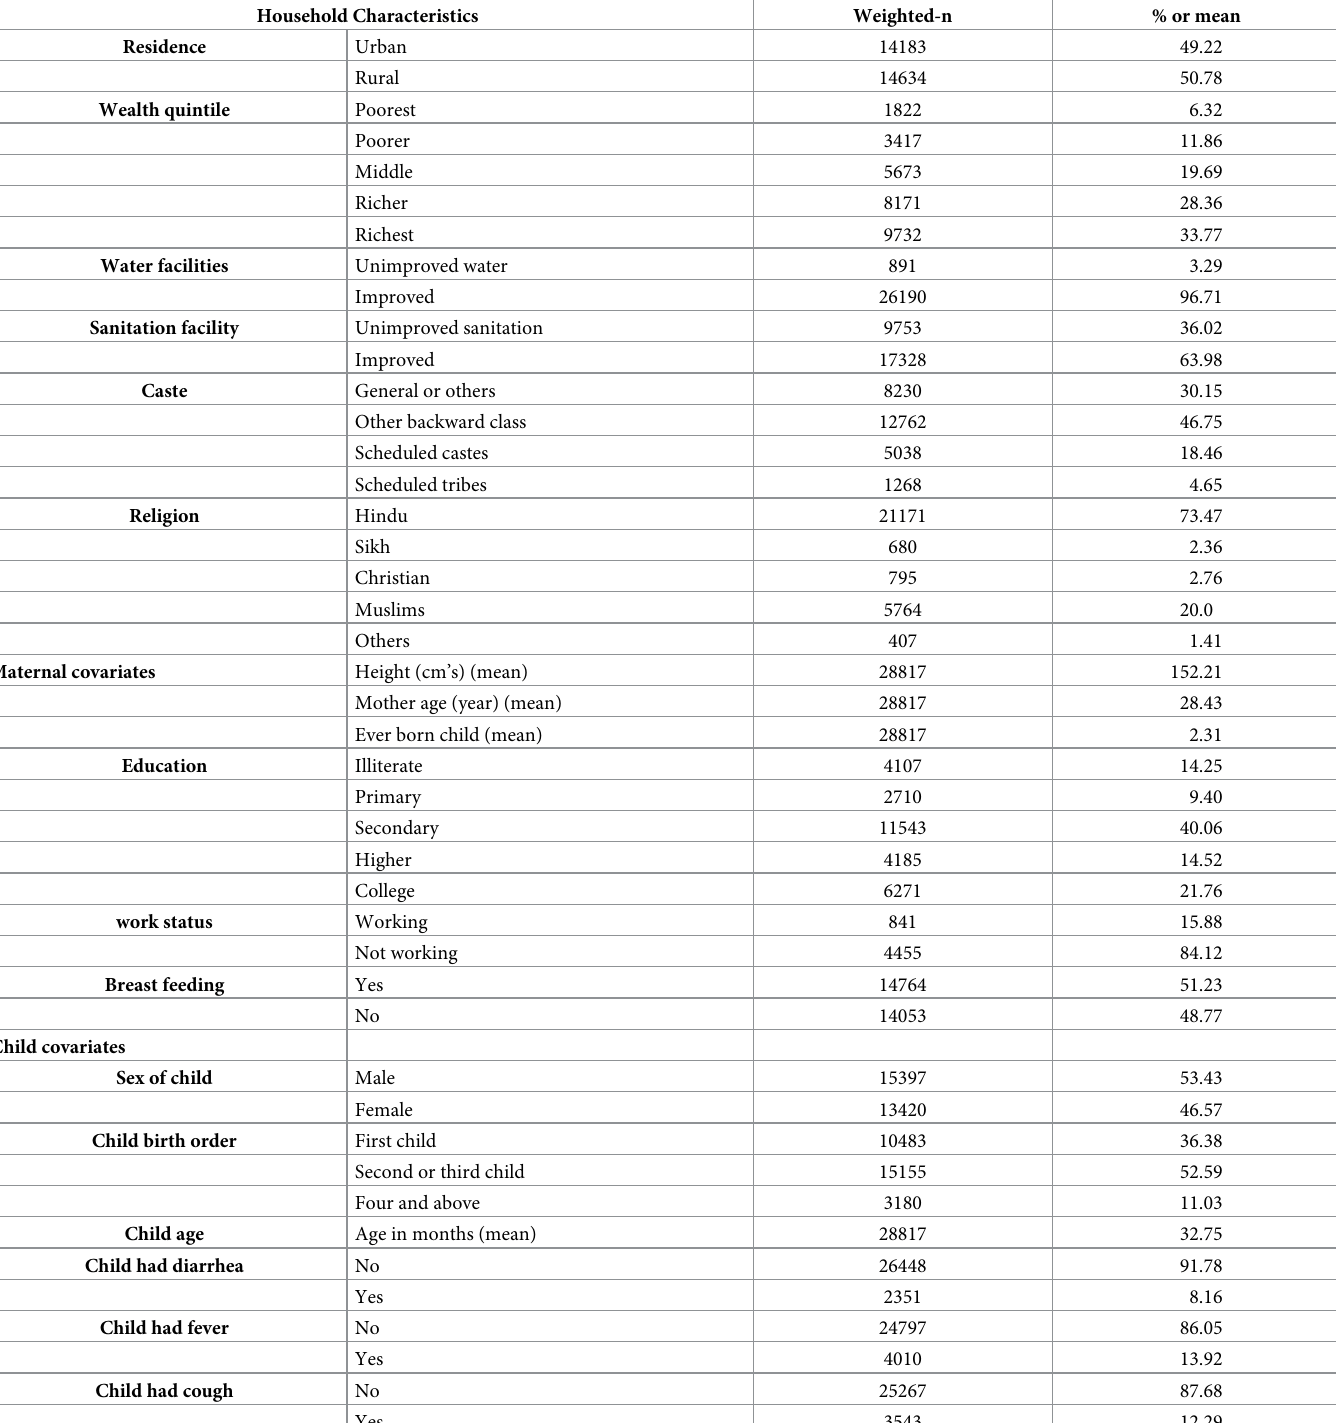
Table 1. Sociodemographic characteristics of the respondents, NFHS-4 (2015–16),